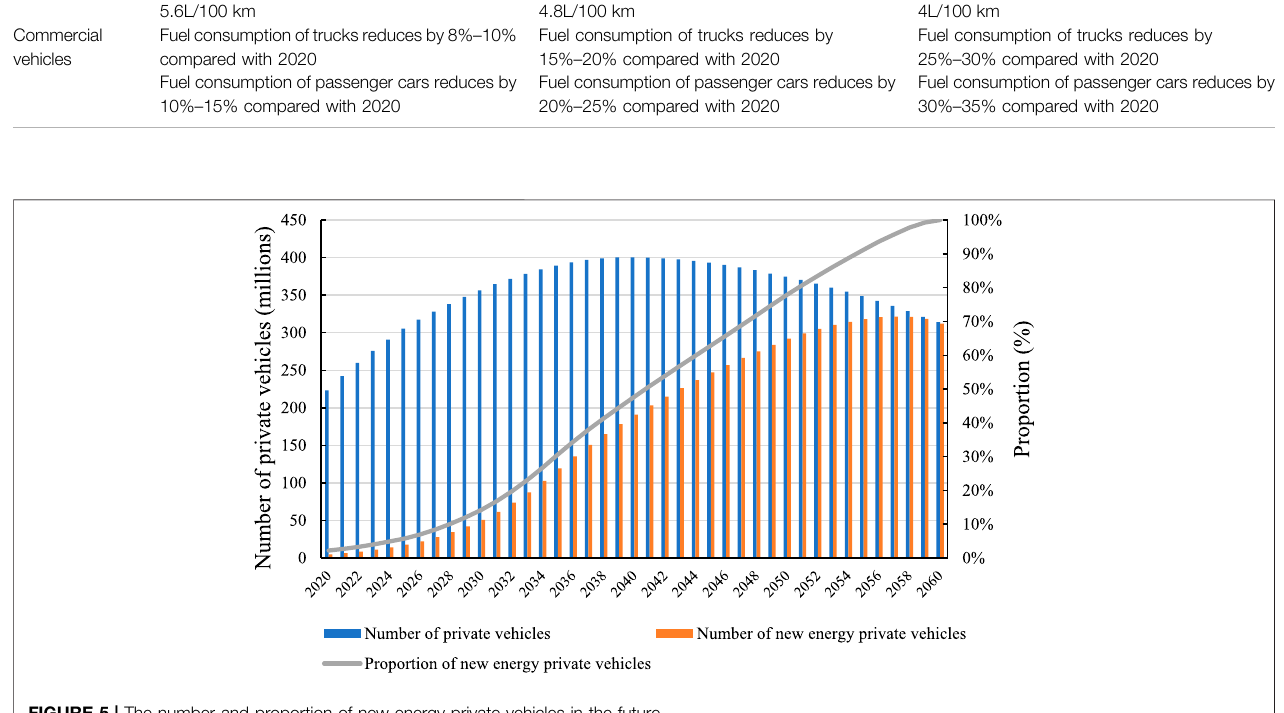
FIGURE 5 | The number and proportion of new energy private vehicles in the future.